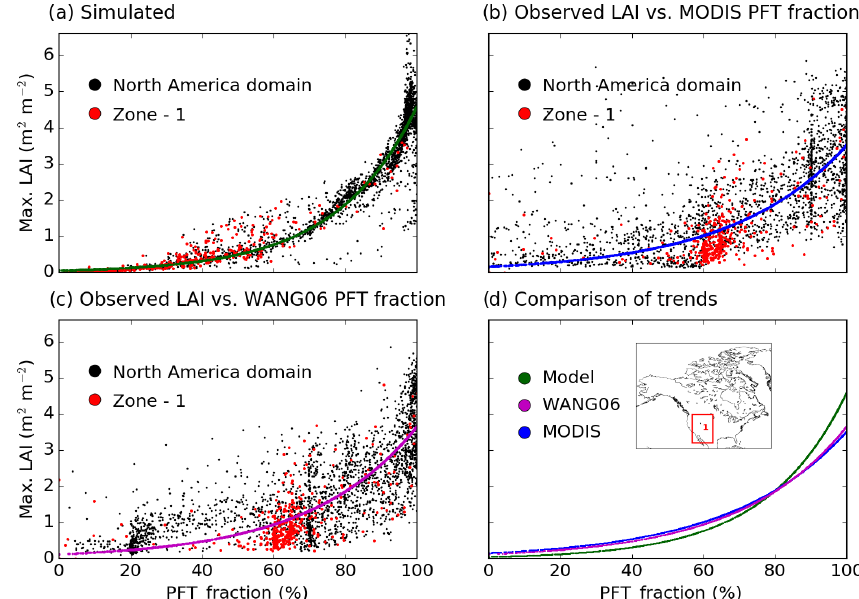
Figure 12. Scatterplots of (a) simulated LAI vs. simulated total vegetation coverage, (b) observed LAI vs. MODIS-derived total vegetation coverage and (c) observed LAI vs. WANG06 total vegetation coverage. (d) Comparison of the fitted curves represented by solid lines, with an inset map of North America showing the subdomain of interest bounded by a red